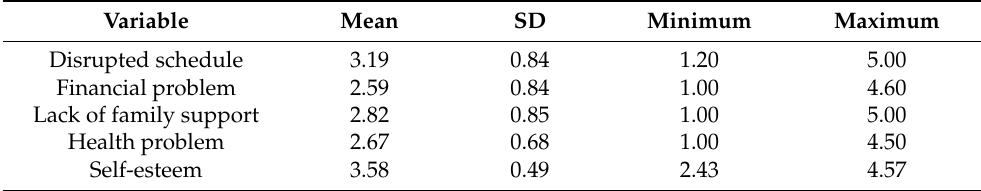
Table 3. Caregiver burden ( n = 107).